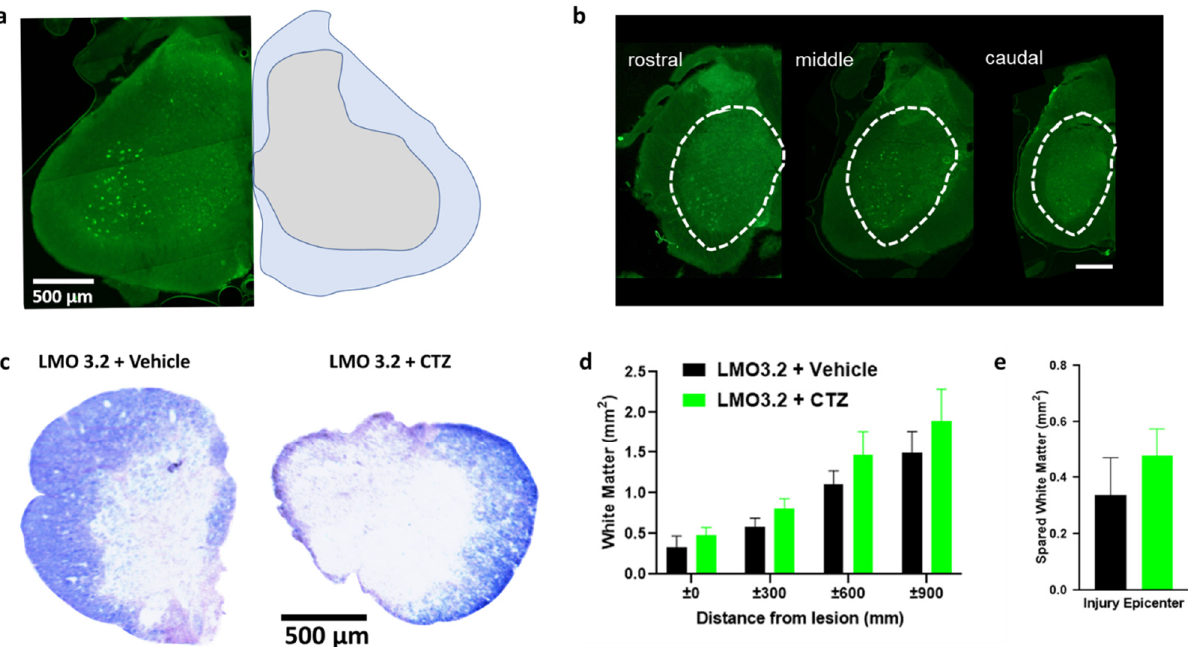
Figure 6. AAV-hSyn-LMO3.2-EGFP expression, eriochrome cyanine staining and quantification of spared white matter around and within the injury epicenter. ( a ) AAV-hSyn-LMO3.2-EGFP expression ( left ) and anatomical annotations ( right ). ( b ) There is robust viral transduction of the lumbar region of the spinal cord. ( c ) Eriochrome cyanine staining shows similar loss of white matter within the injury epicenter of vehicle- and CTZ-treated groups. ( d , e ) All animals were uniformly injured and there was no statistically significant difference between the two groups. Data are presented as mean ± SEM.